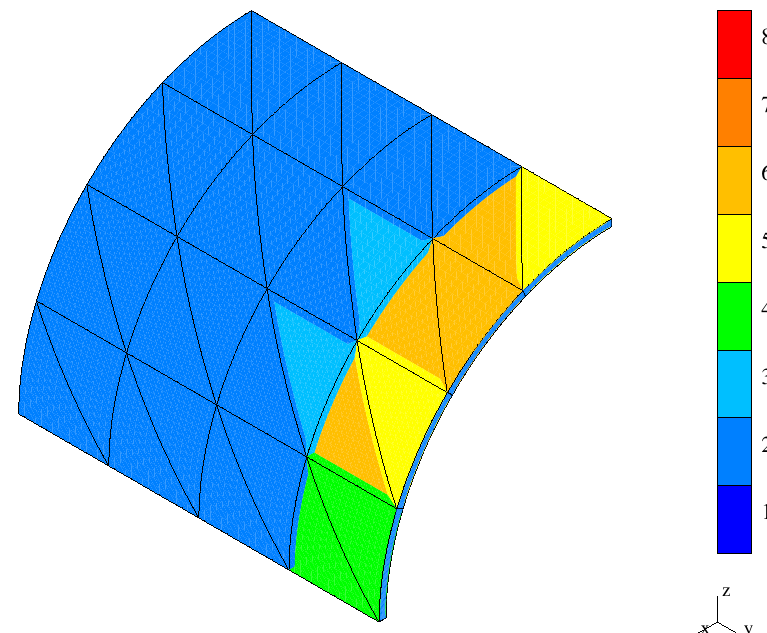
Figure 28. An octant of a membrane-dominated shell— hp -adapted (final)